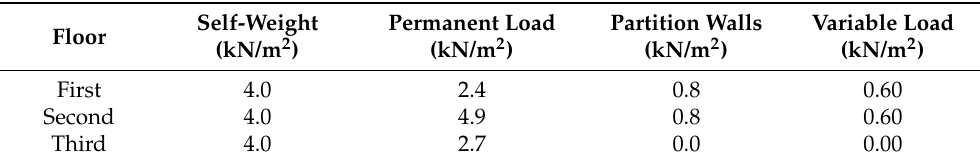
Table 5. Self-weight, permanent loads and variable load in seismic conditions.